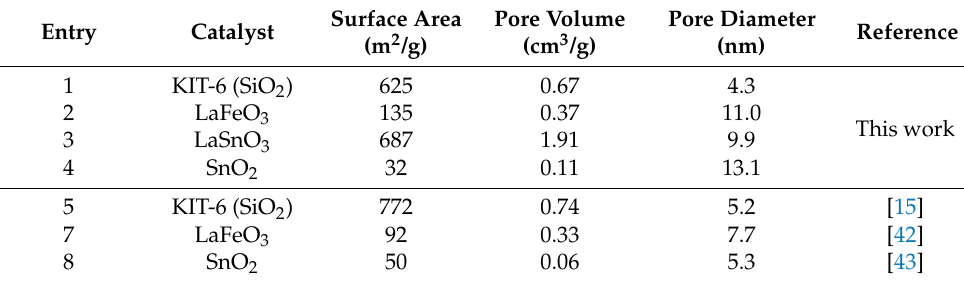
Figure 2. Nitrogen sorption isotherms for the synthesized catalyst materials ( a ) and their corre- sponding pore size distributions ( b ). The LaSnO 3 isotherm was vertically translated by 214.7cm 3 /g and that for KIT-6 by − 3.6 cm 3 /g.